Question: In one sentence, what is this figure communicating?
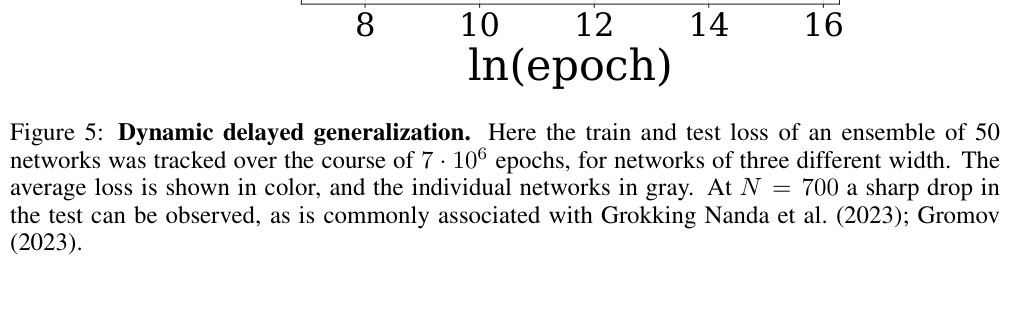
Answer: plots the train and test loss and Fig. 6 tracks the projection of the average network output on different normalized components of the target, as a function of the number of training steps for the different network widths and averaged over an ensemble of 50 networks. Where we define the linear component of the network to be- H1(w∗· x), and the cubic component as- ϵH3(w∗· x), and x is taken either from the test or the train dataset. Thus if the projection of the network on a certain normalized component is near one, it has been learned entirely by the network.